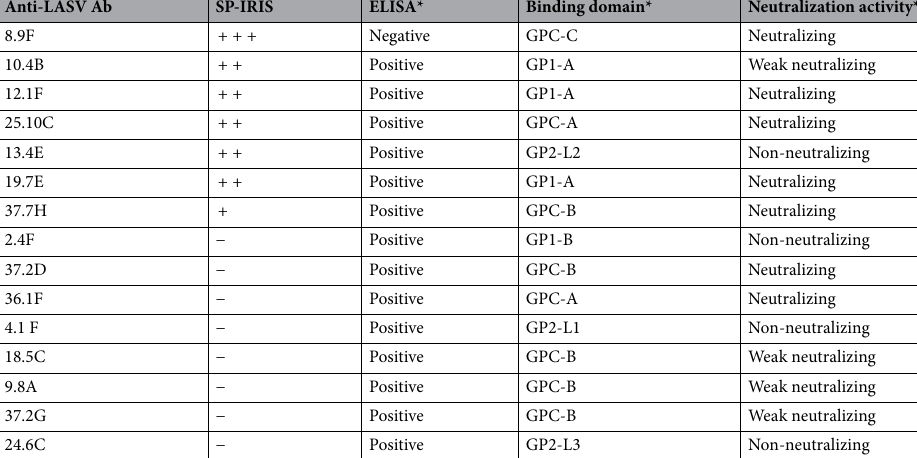
Table 2. The mAbs against LASV GP tested on SP-IRIS, observed SP-IRIS signal levels, signal on ELISA, binding domains on GP, and neutralization activities. The degree of binding on SP-IRIS is denoted by the number of + symbols: + + + high, + + medium, + little, − no binding. *Antibody information given in the last three columns was obtained from 49 . 19.5A is not included in the table since there is no information on the binding domain or neutralization